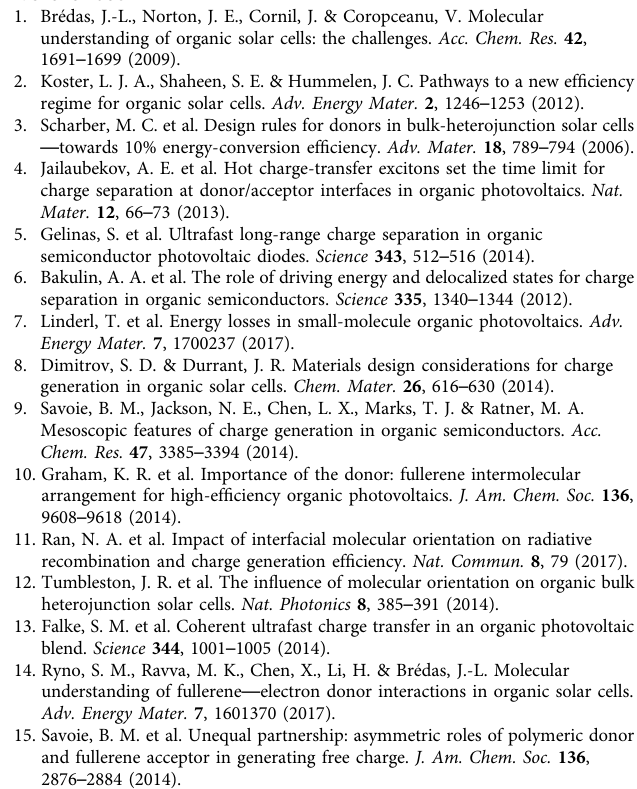
Fig. 6 Low Urbach energy is necessary for large internal quantum ef fi ciencies. a Estimation for the average distance to CT-state trap sites as a function of Urbach energy. Here, we de fi ne a trap site as any site with an energy > 25 meV < E g − 0.1 eV. b η IQE vs energy loss ( E g − V OC ) for a variety of polymer-fullerene blends. The colour of the marker denotes its Urbach energy. For the PDPP series, X is T, 2T, BDT and DTP